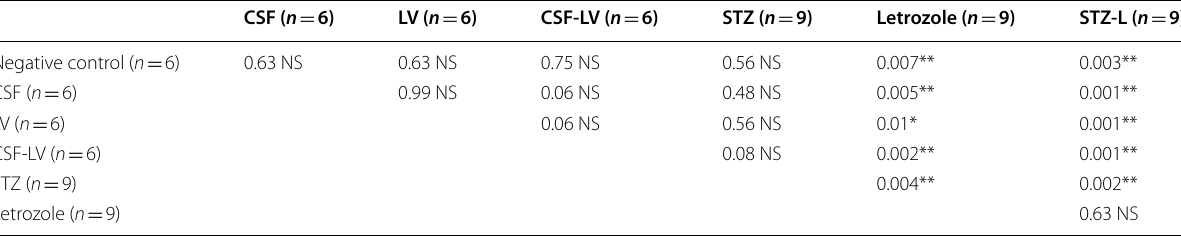
Table 4 LSD for Let‑7b fold change among different studied